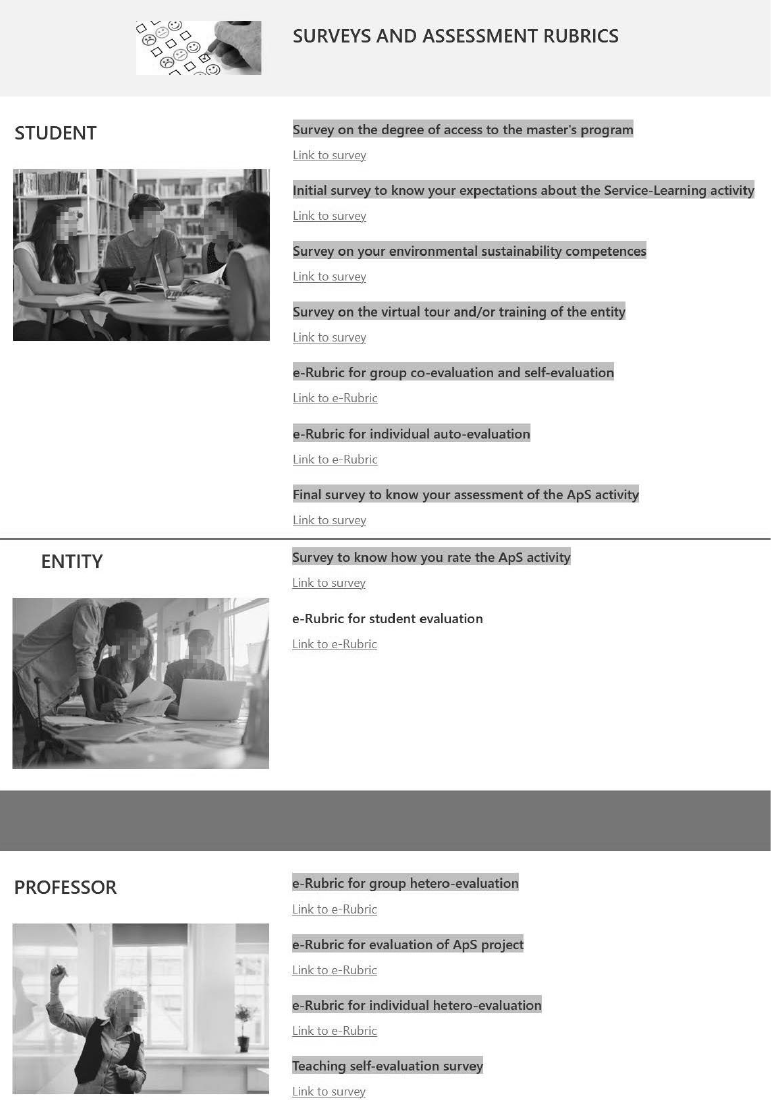
Figure 2. Workspace using the e-learning platform: space for surveys and rubrics from students, entities, and